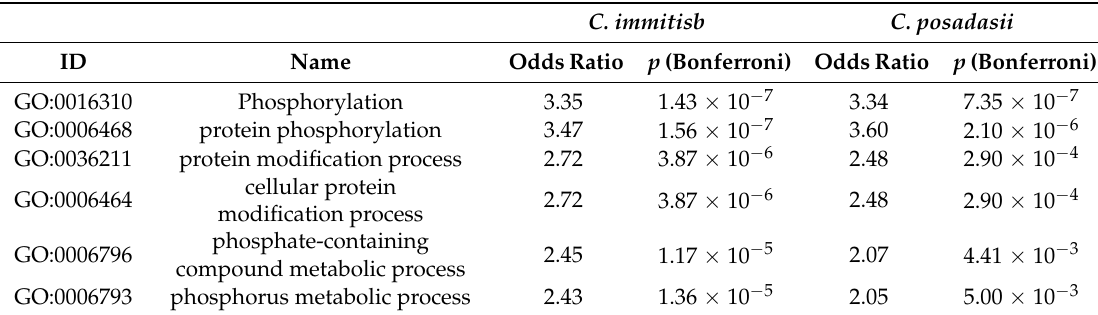
Table 5. GO enrichment analysis of genes associated with